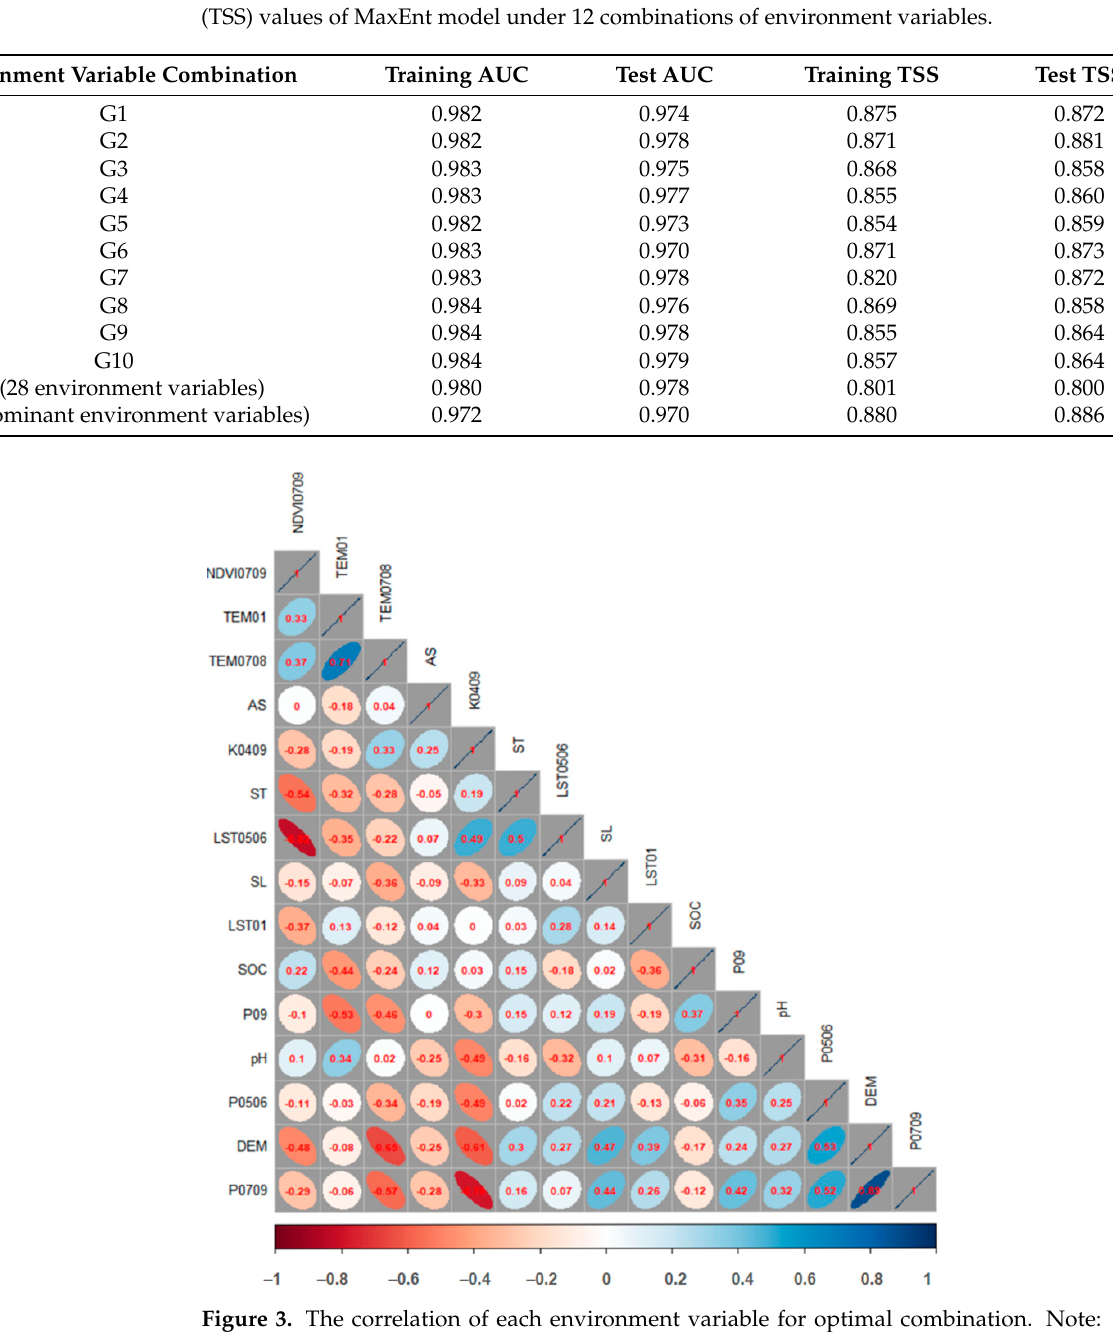
Figure 3. The correlation of each environment variable for optimal combination. Note: TEM01 and TEM0708 represent air temperature in January and from July to August. LST0506 and LST01 represent land surface temperature from May to June and in January. DEM, AS, and SL represent altitude, aspect, and slope. K0409 represents aridity index from April to September. P0709 and P09 represent total precipitation from July to September and in September. ST and SOC represent soil texture and soil organic carbon. NDVI0709 represents NDVI from July to September.